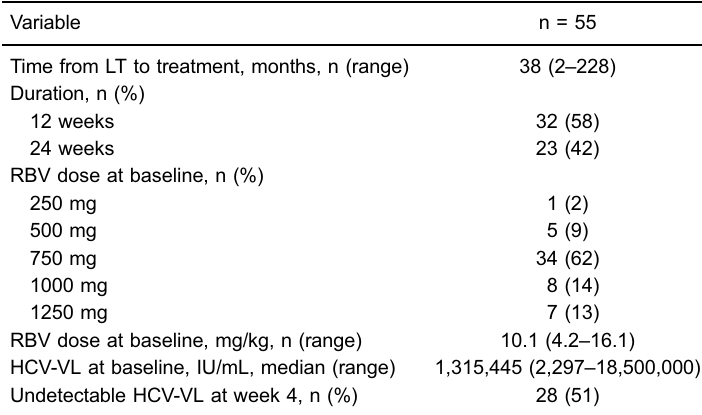
Table 2. Antiviral treatment